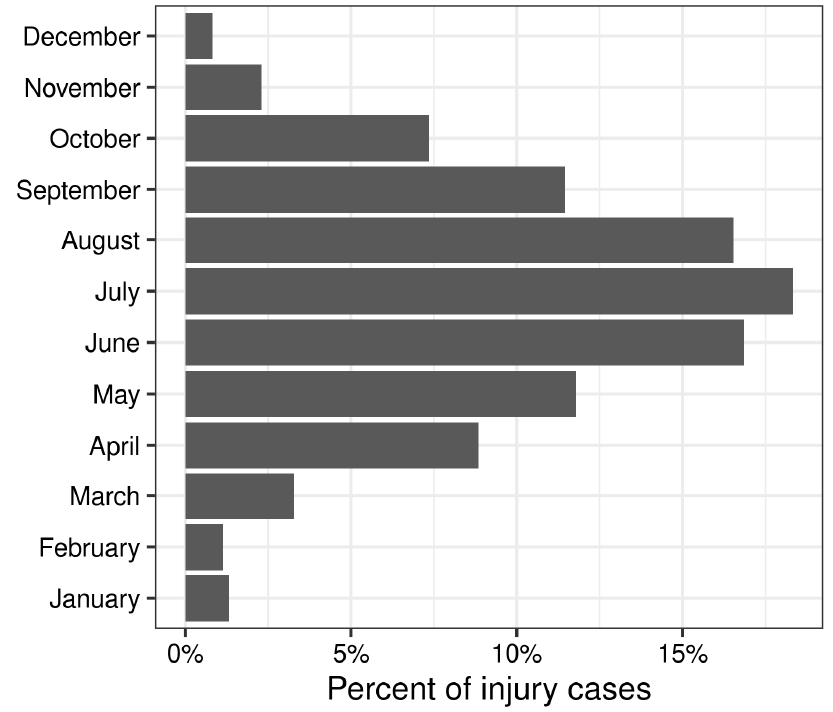
Figure 1. Percentage of total injury counts per month. Aggregated over the 1 March 2015–28 February 2021 time period.